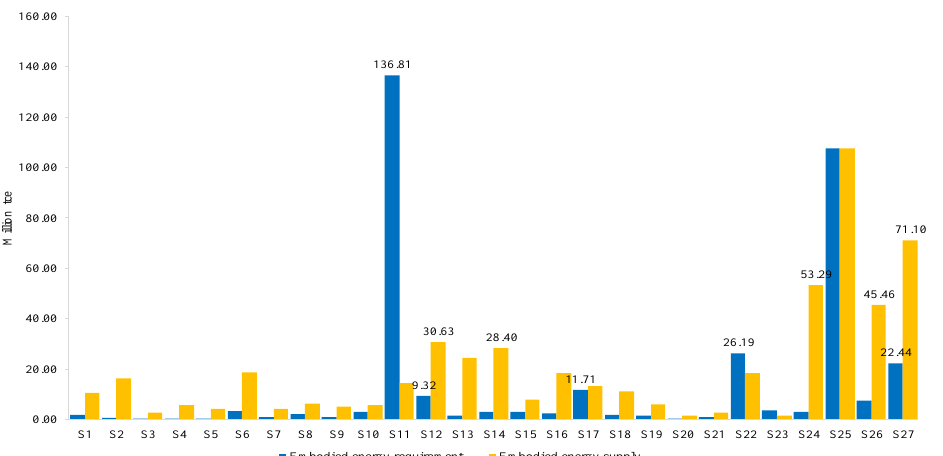
Figure 4. The embodied energy flows of transport sector with other sectors.